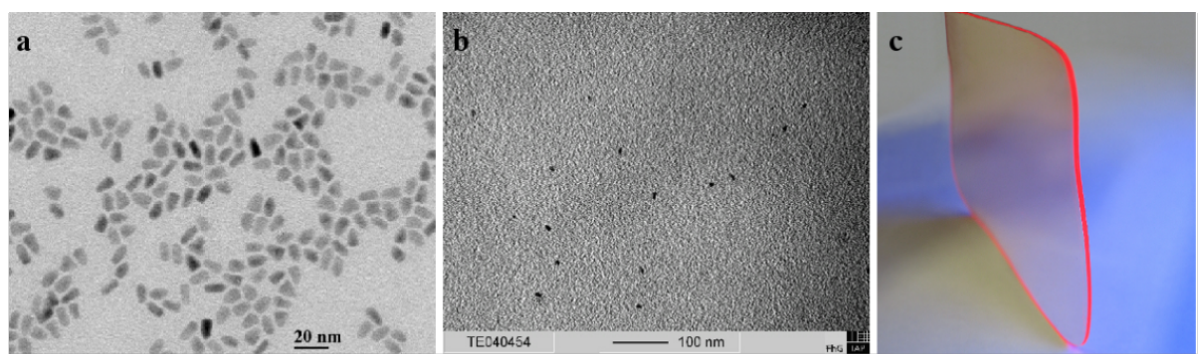
Figure 5: a) TEM image showing bullet shaped CdSe/CdS nanoparticles (aspect ratio 3), b) the NRs in the P(LMA- co -EGDM) matrix, and c) a photo of a NR/polymer composite (0.05 wt % NRs) illuminated with UV-radiation (365 nm).